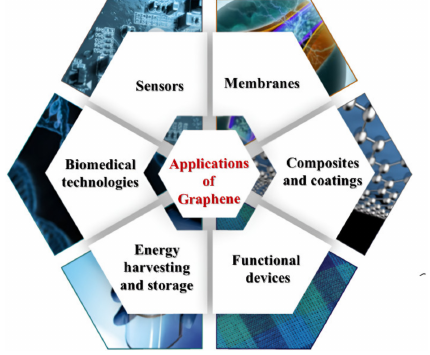
Figure 5. Potential Applications of